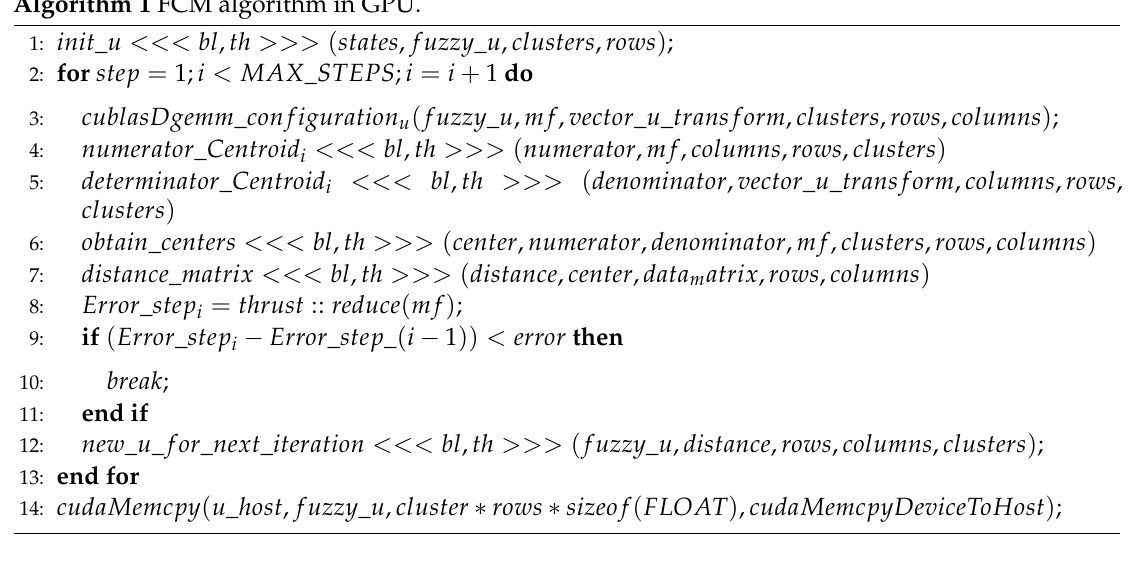
Algorithm 1 FCM algorithm in